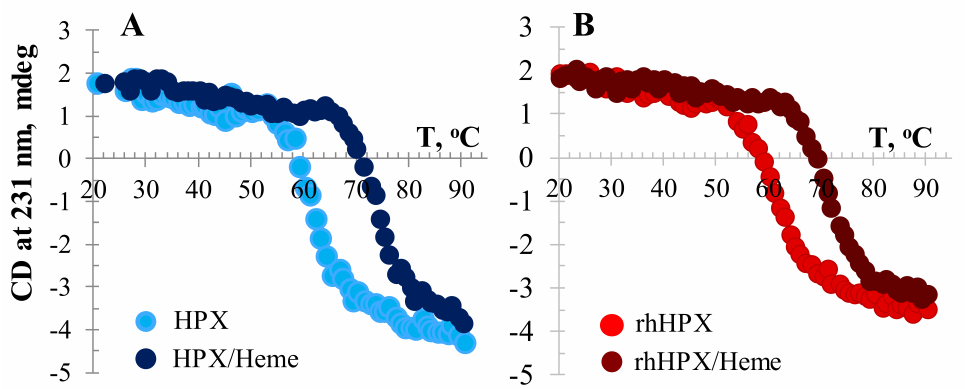
Figure 7. Temperature-induced CD changes: ( A ) Plasma HPX and HPX/Heme at an L/P of 1.0 and ( B ) rhHPX and rhHPX/Heme at an L/P of 1.0. Temperature-induced CD data suggest that heme binding to rhHPX stabilizes the protein structure as indicated by a T m = 71 ± 0.5 ◦ C observed for the rhHPX/Heme complex (L/P of 1.0) in comparison with that of apo rhHPX (T m = 62 ± 0.5 ◦ C). Although the CD melting profiles for the recombinant and plasma samples are not identical, the melting points of the complexes approximate each other. In comparison with the data collected for apo-proteins, these results demonstrate that both rhHPX and plasma HPX are largely stabilized by bound heme. The T m values determined here for plasma apo HPX and HPX/Heme appear to be slightly different than values obtained using differential